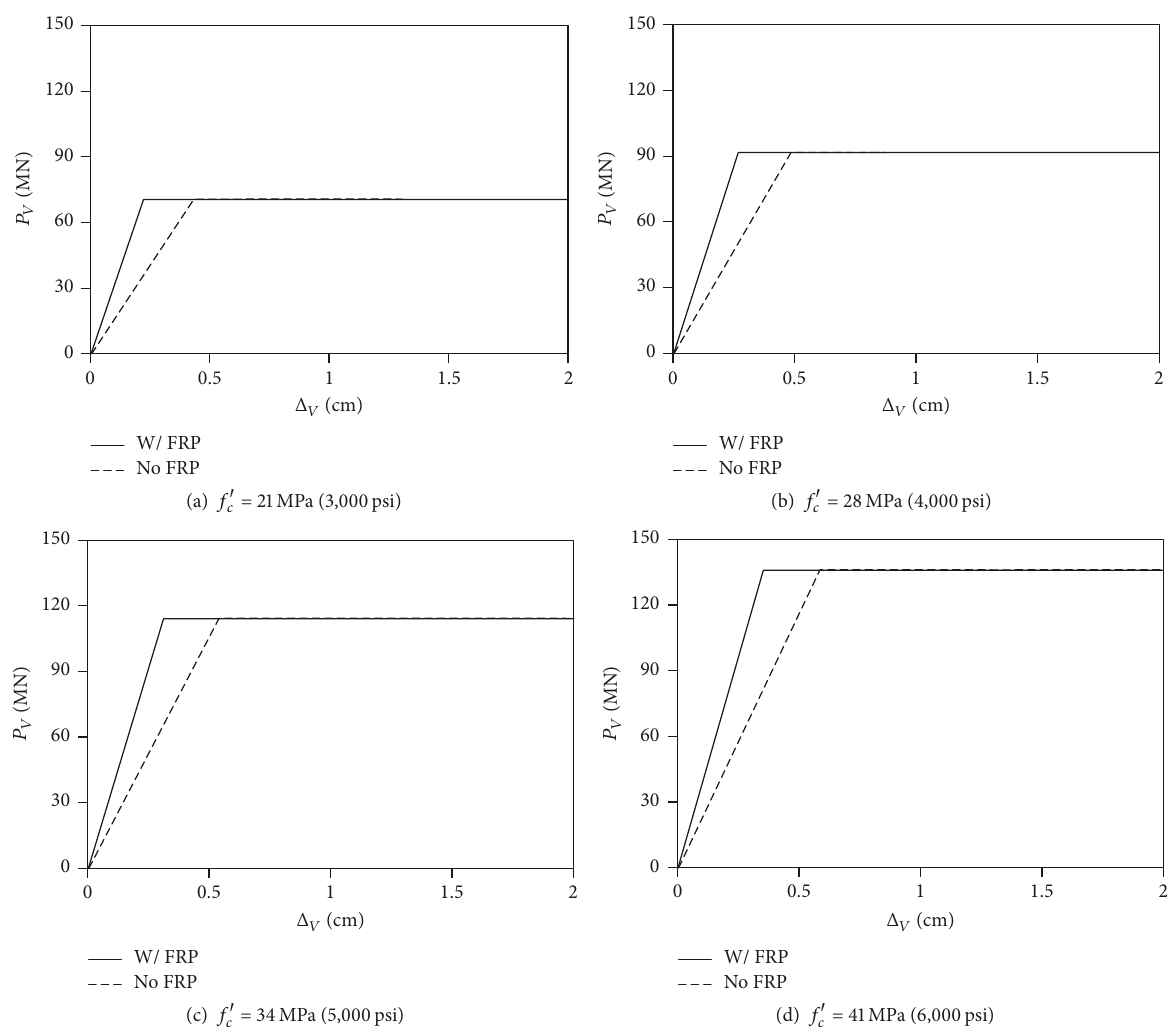
Figure 6: Pier section (1.5m by 1.5 m) subjected to vertical loads (thickness of FRP wrap = 3.3